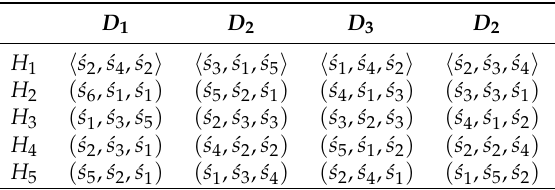
Table 1. Linguistic picture fuzzy